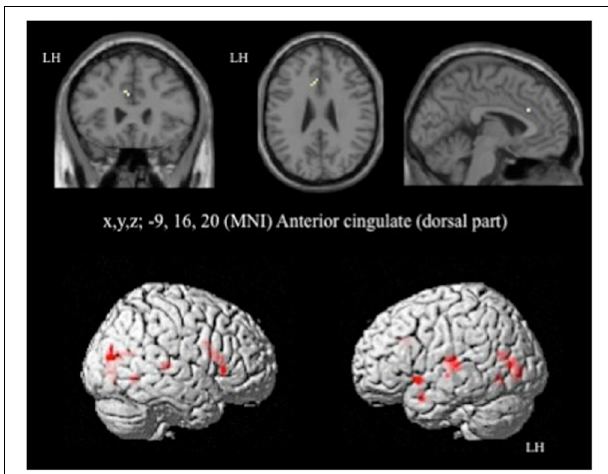
FIGURE 4 | Brain activation during the emotional Stroop task (contrast: Incongruent vs. Congruent with all faces) in healthy subjects. p < 0 . 001, k > 5, n = 12, uncorrected. LH, left hemisphere; MNI, Montreal Neurological Institute.